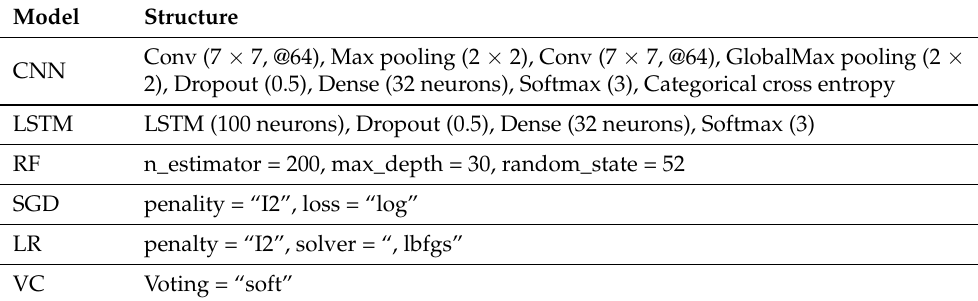
Table 2. The layer structure and hyperparameters of the learning